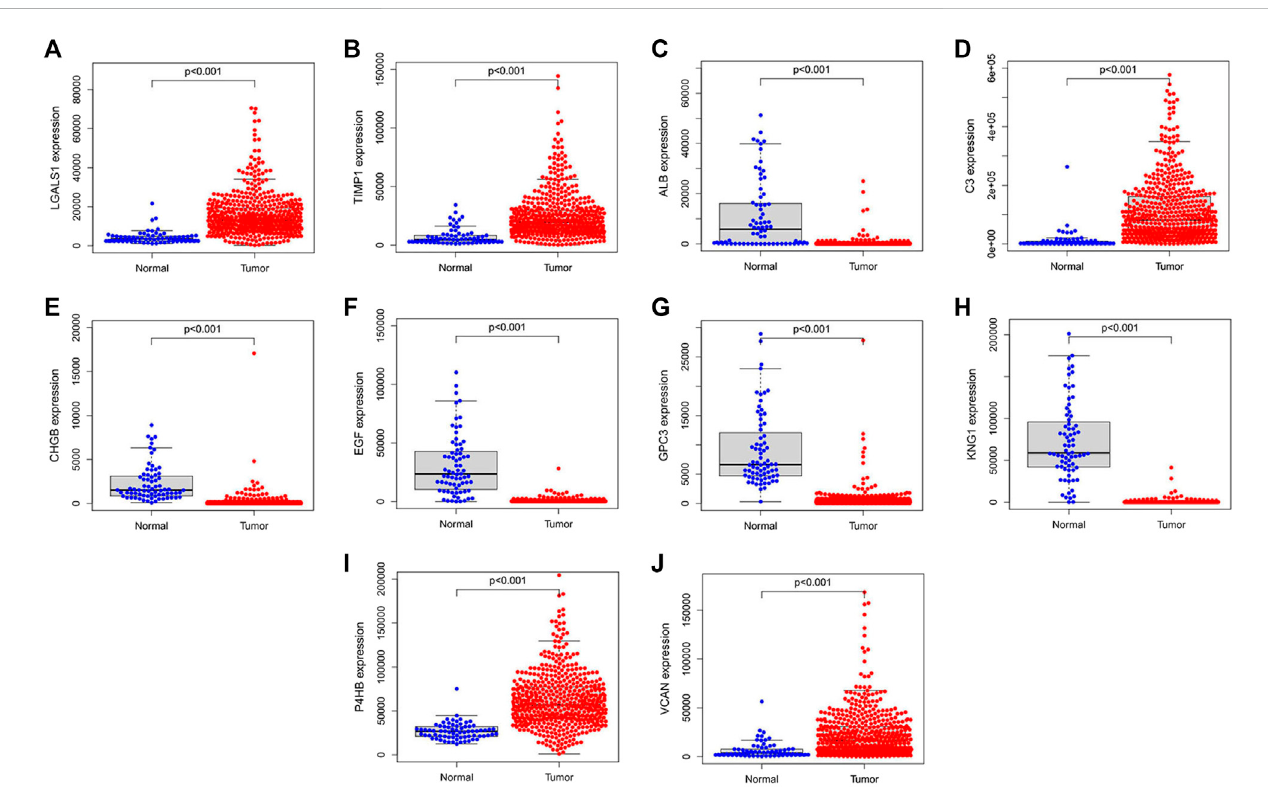
FIGURE 7 Hub genes validation using TCGA dataset. (A) The expression of LGALS1 in tumor and normal tissues in patients with ccRCC. (B) The expression of TIMP1intumorandnormaltissuesinpatientswithccRCC. (C) TheexpressionofALBintumorandnormaltissuesinpatientswithccRCC. (D) Theexpressionof C3 in tumor and normal tissues inpatients with ccRCC. (E) The expression of CHGB in tumor and normal tissues in patients with ccRCC. (F) The expression of EGF in tumor and normal tissues in patients with ccRCC. (G) The expression of GPC3 in tumor and normal tissues in patients with ccRCC. (H) The expressionofKNG1intumorandnormaltissuesinpatientswithccRCC. (I) TheexpressionofP4HBintumorandnormaltissuesinpatientswithccRCC. (J) The expression of VCNA in tumor and normal tissues in patients with